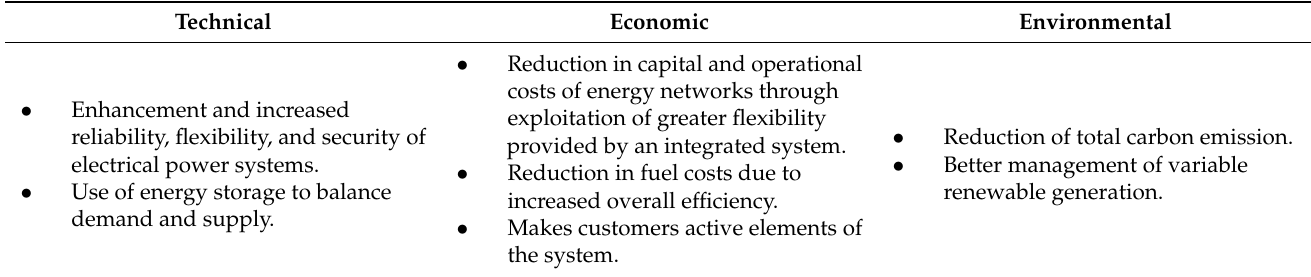
Table 2. Benefits of multi-vector energy systems [49].